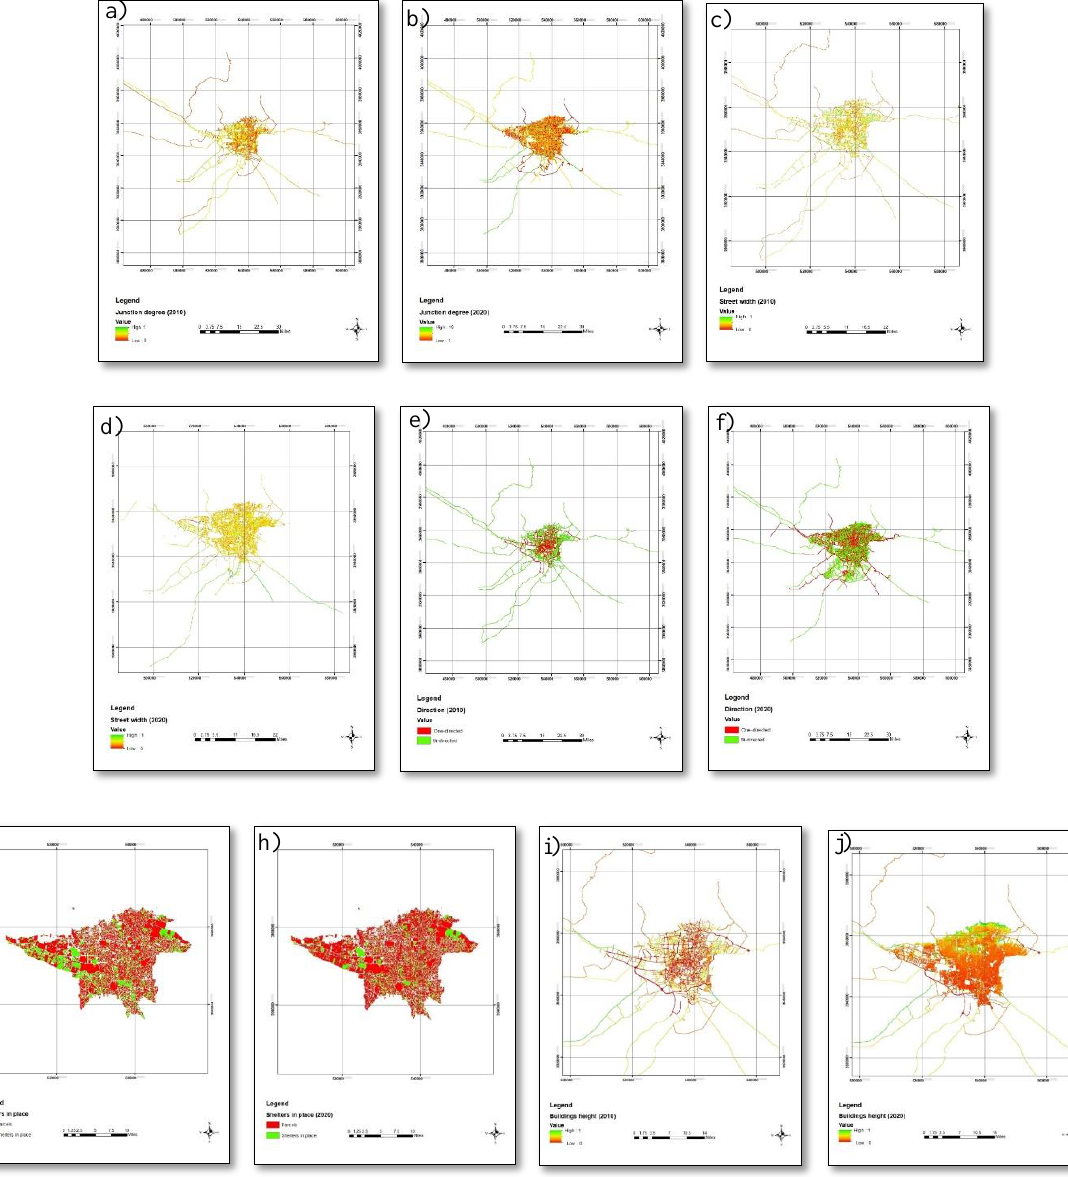
Figure 3. Normalized criteria maps for 2010 and 2020